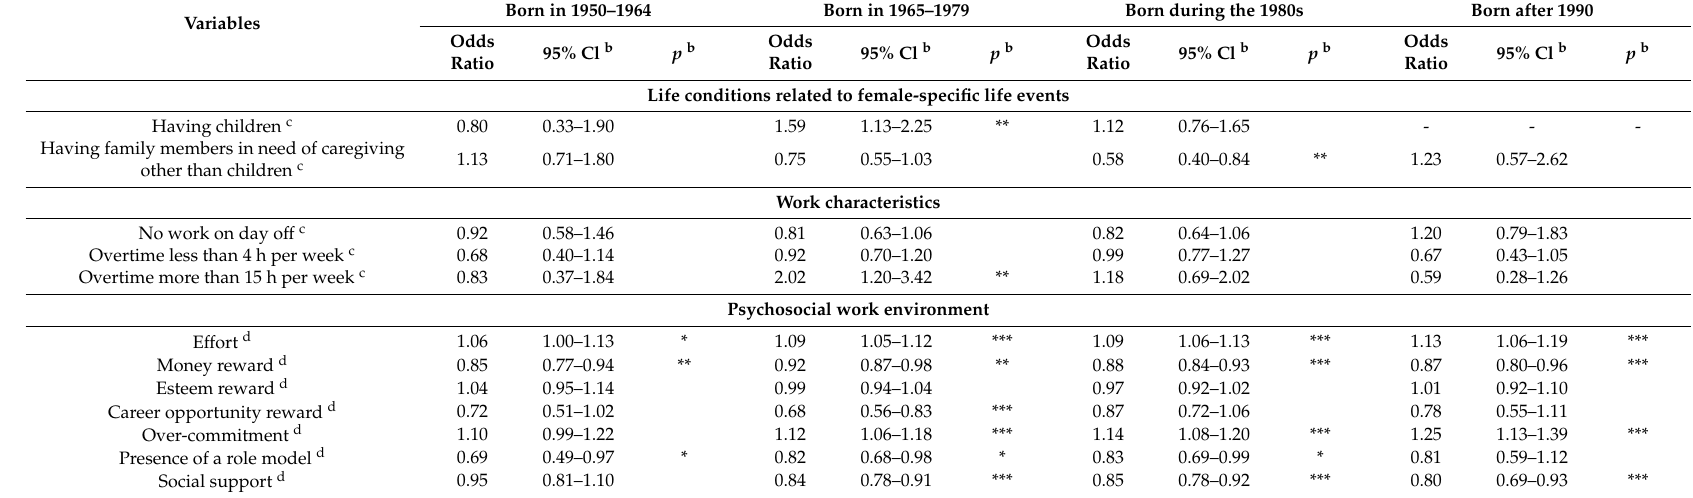
Table 4. Results of multivariate logistic regression for the upper quartile of intention to leave scores among female participants in four generations a .